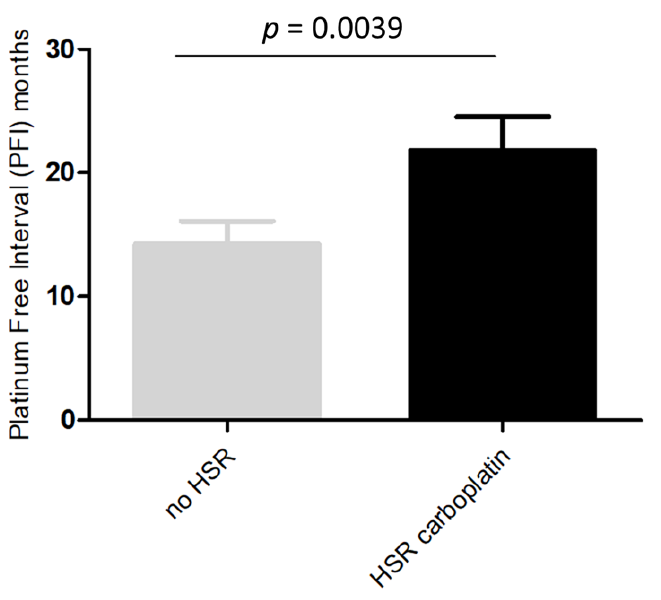
Figure 2. Platinum free interval in patients with and without immediate-HSRs to CBDCA.